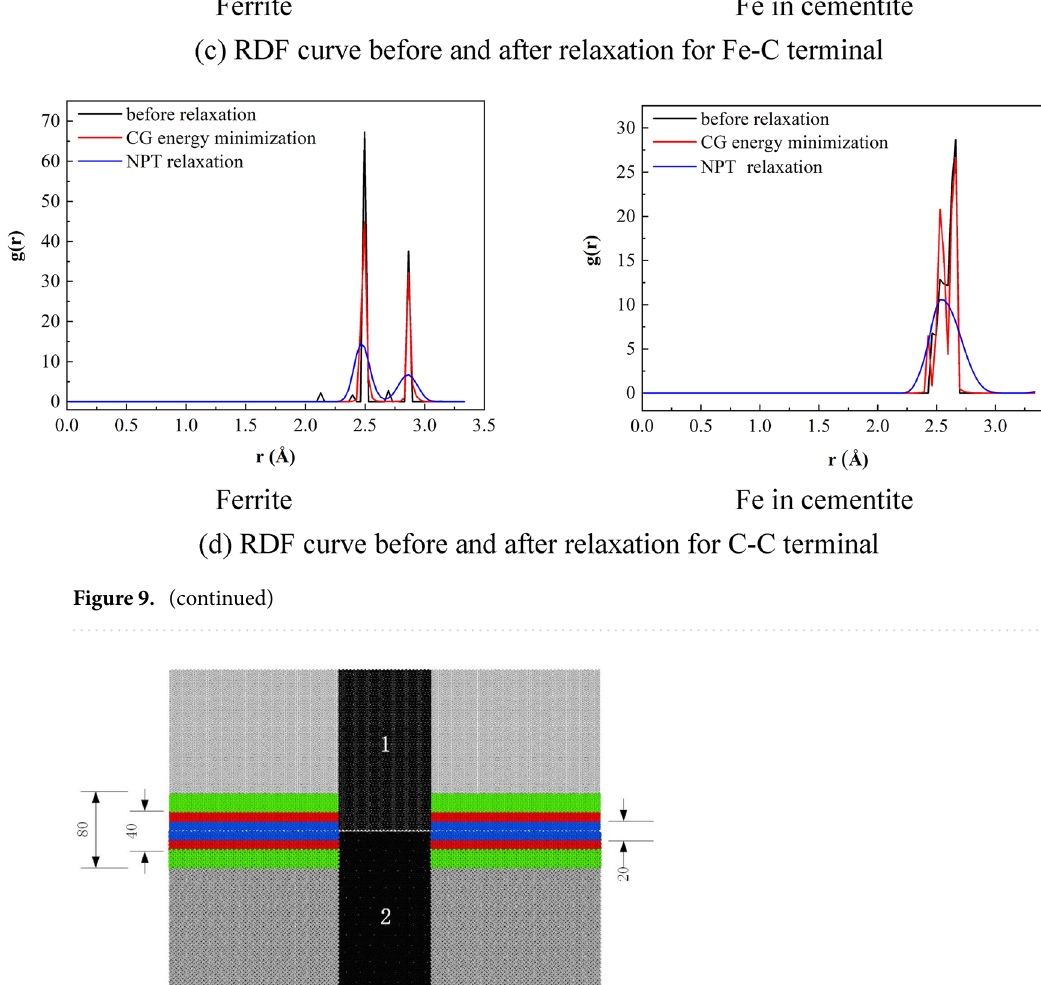
mation at the crack tip. Figure 12b corresponds to the instantaneous model when the strain is 2.54% at 50.8 ps. With the further enhancement of plastic strain, the interaction between a few atoms decreases, and voids appear between atoms. With the expansion of voids, voids between atoms are formed. Figure 12c corresponds to the instantaneous model at 52.6 ps and strain of 2.63%. With the increase of interatomic vacancies, holes are gradu- ally formed at the trailing edge of the crack tip (as shown in the white circle in Fig. 12c). With the growth and aggregation of holes, the upper and lower interfaces slowly separate, the interface cracks and forms a new crack tip, and the protons pile up again at the new crack tip (as shown in the yellow circle in Fig. 12c). After repeating